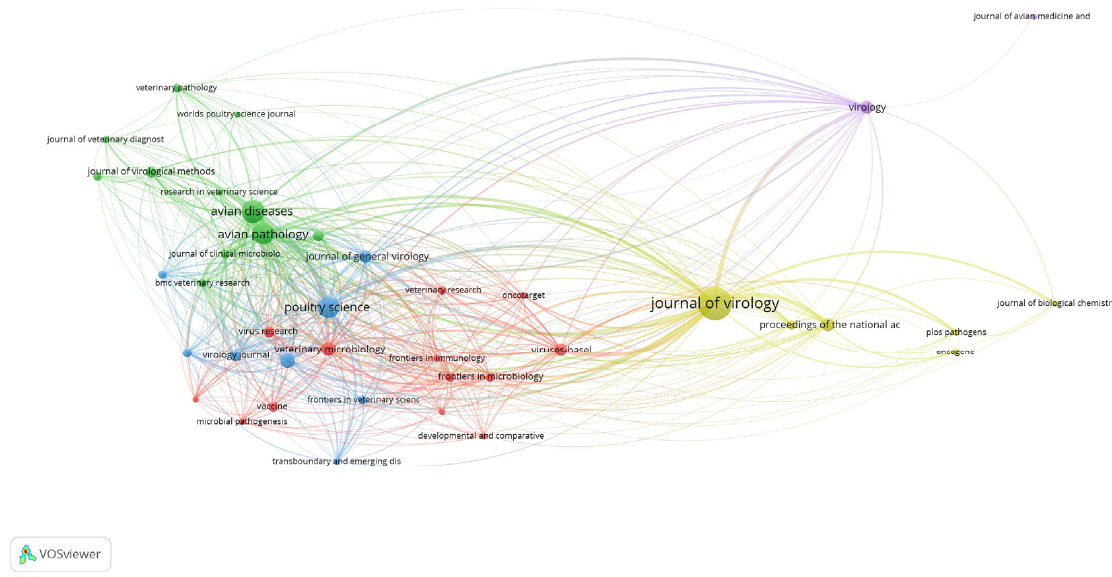
Figure 1. The most influential journals in the avian leukosis virus research. The node size represents the total articles published.